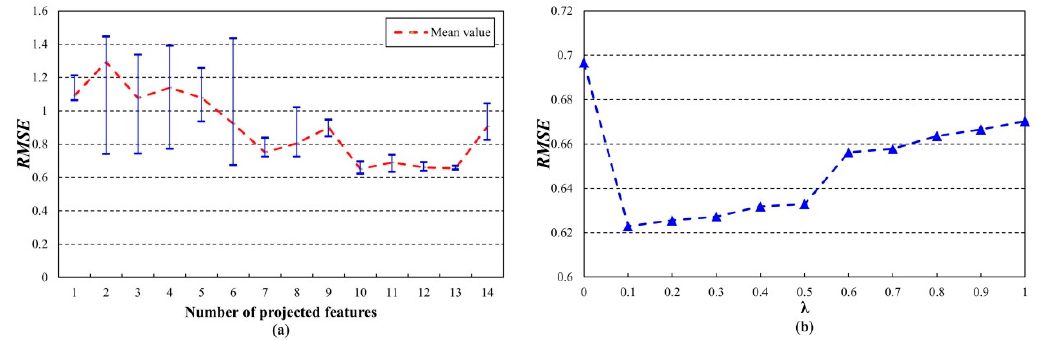
Figure 3. Performance of SSTCA-SVR on Bear Fire with respect to two parameters: ( a ) the number of projected-features and ( b ) λ . Note that the SSTCA-SVR has the lowest RMSE value, with number of projected features set to 10. After this setting, the optimal value for λ was 0.1.